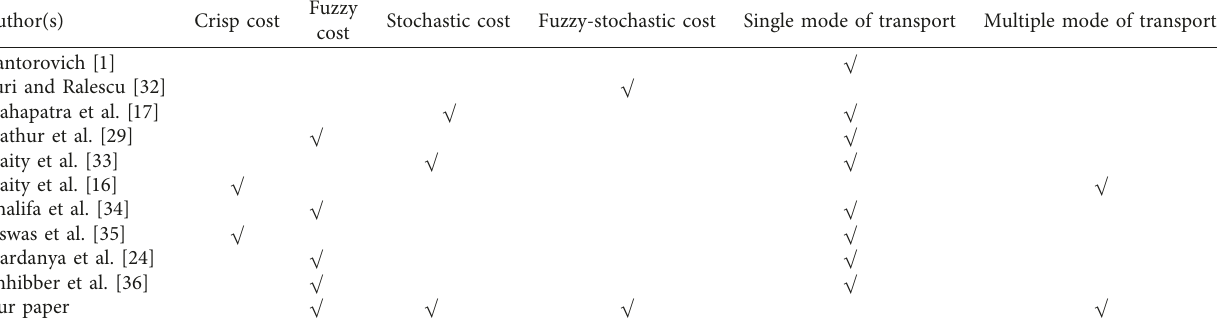
Table 1: Contributions of different authors related to TP under